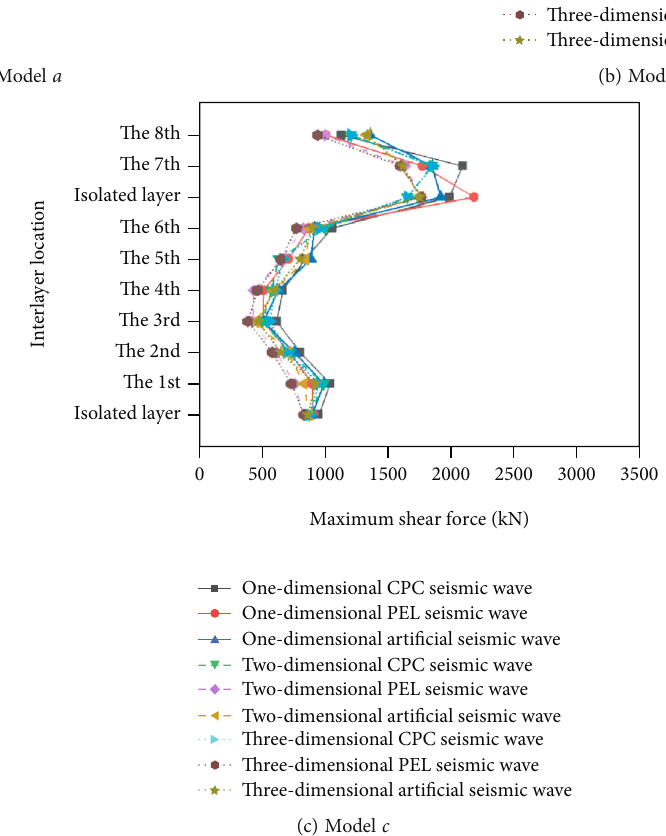
Figure 7: Comparison of interlayer shear force in X -direction of di ff erent